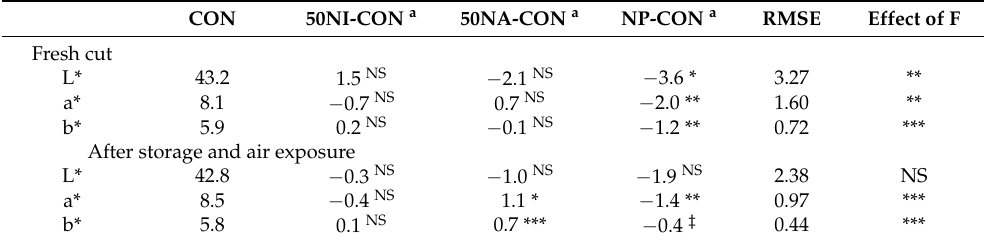
Table 2. Instrumental color parameters of dry-fermented sausages.